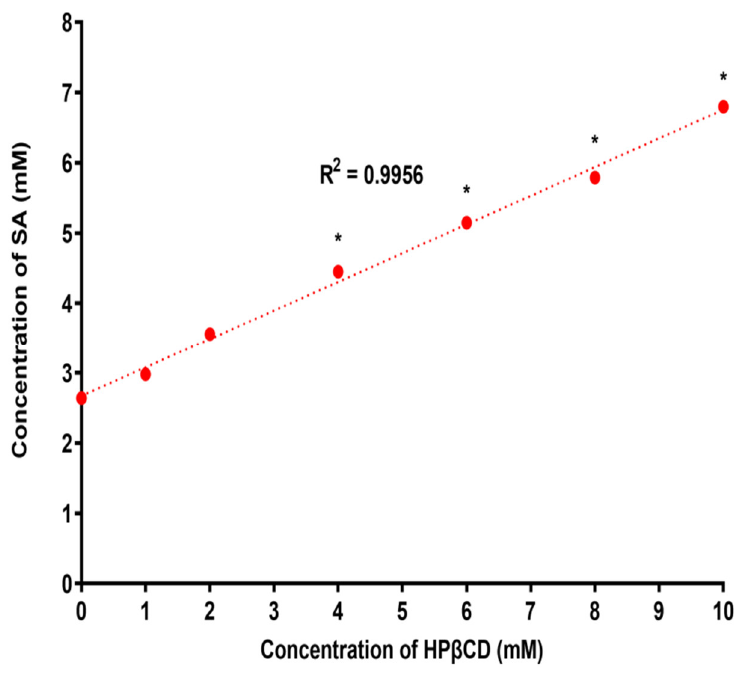
Figure 6. Phase solubility graph of SA in presence of HP β CD. * p < 0.05 as compared to S 0 .